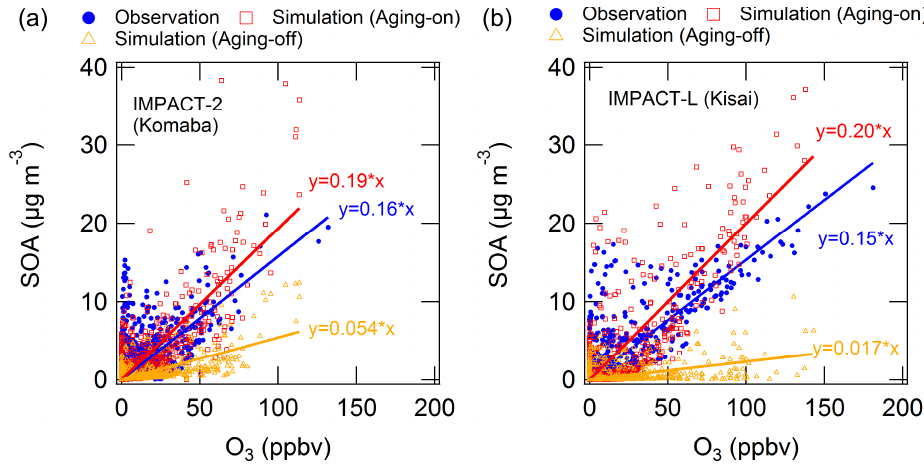
Figure 5. Correlation of SOA mass concentrations with O 3 volume mixing ratios (a) at Komaba during the IMPACT-2 campaign and (b) at Kisai during the IMPACT-L campaign. Solid lines show the fitting slopes ( y = ax ) for observation (blue) and simulations with (red) and without (orange) aging processes of organic vapors.